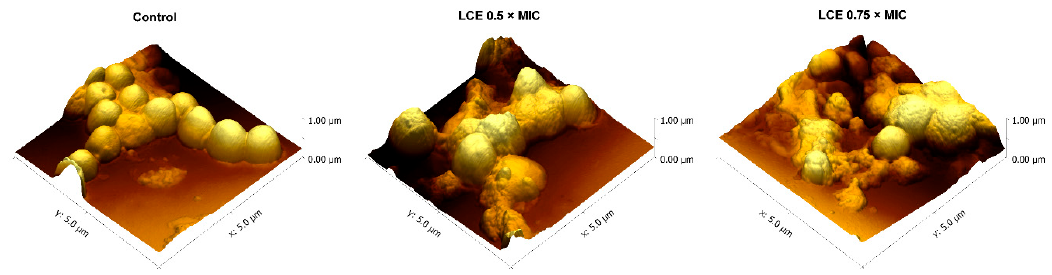
Figure 1. Atomic force microscopy (AFM) images of S. aureus 8325-4 control cells and the cells exposed on L. cardiaca L. extract (LCE) at 0.5 × MIC or 0.75 × MIC for 24 h.